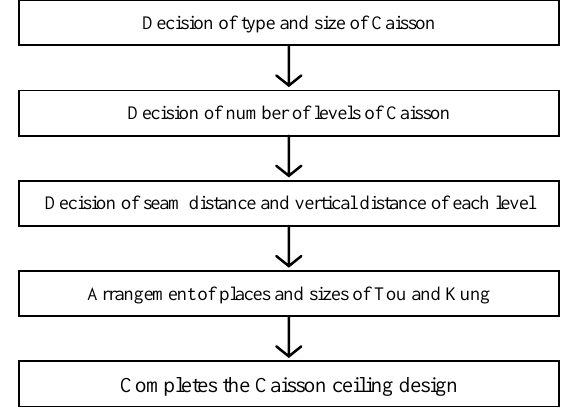
Figure 6. Caisson ceiling design procedure